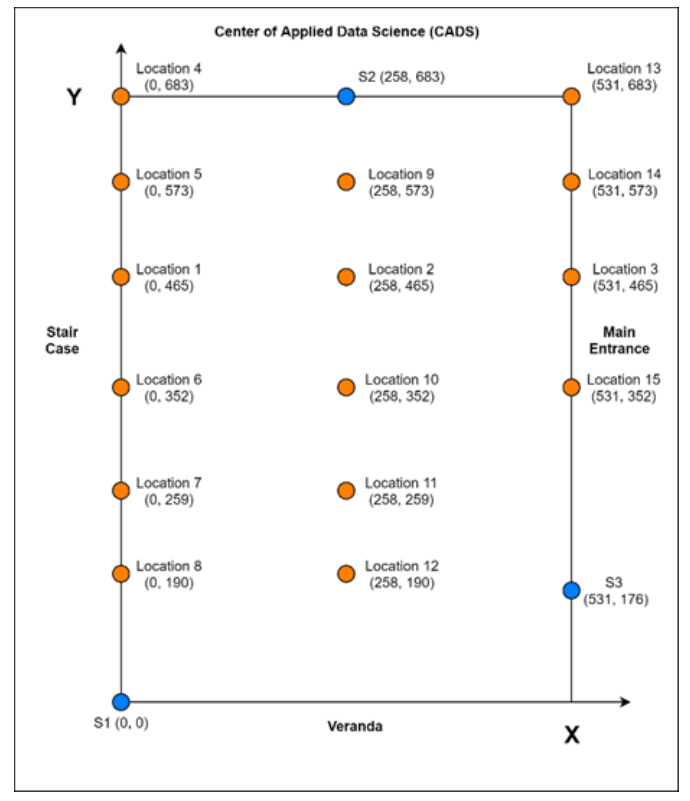
Figure 2. Layout of the indoor space with placements of devices.